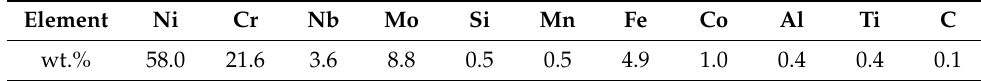
Table 1. Chemical composition of Inconel 625 feedstock.